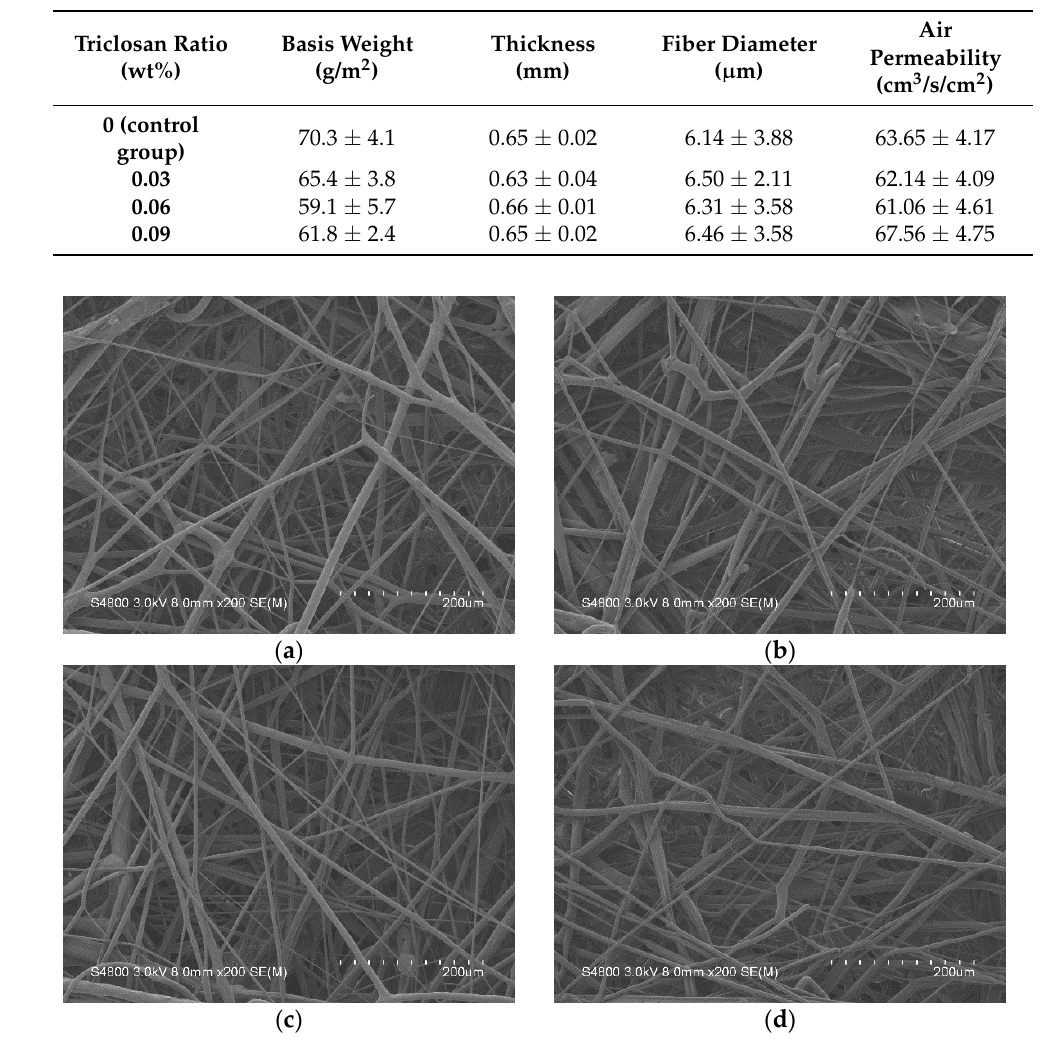
Table 3. Effects of triclosan amount over the physical properties of antibacterial electret PP filters.